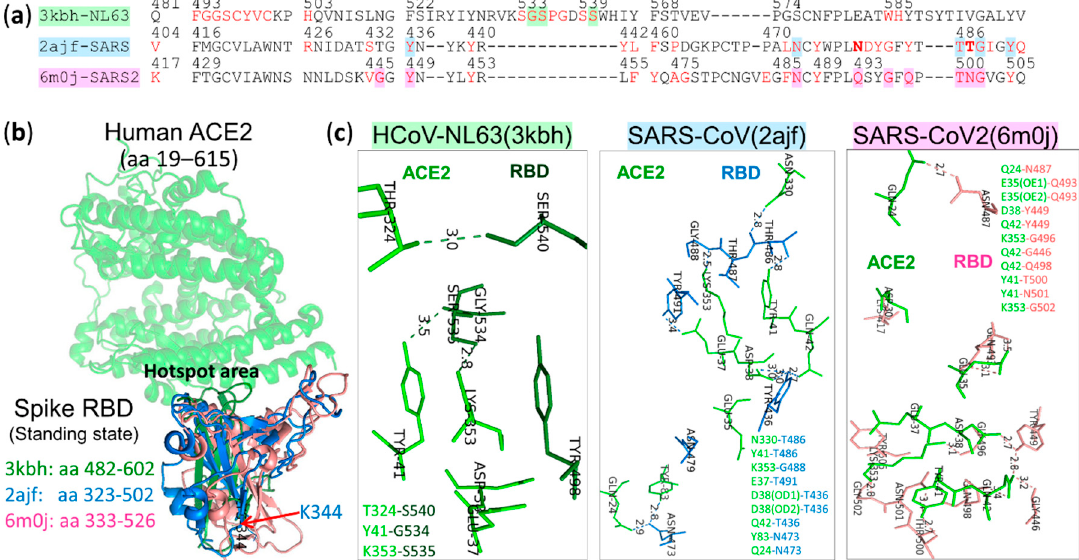
Figure 8. Comparison of receptor binding sites in S1-CTDs of HCoV-NL63, SARS-CoV and SARS-CoV2 binding to human ACE2. ( a ) S1-CTD receptor binding domains (RBDs) of HCoV-NL63 (pdb: 3kbh [232], forest), SARS-CoV (pdb: ajf [234], marine) and SARS-CoV-2 (pdb: 6m0j [235], salmon) in complex with human ACE2 (transparent green). ( b ) Direct interactions between amino acids of human ACE2 and those of the S1-CTD RBD of the indicated CoV. The bond lengths in angstroms are indicated on the dashed lines. ( c ) Alignment of aa sequences of the S1-CTD RBDs of the three CoVs binding to human ACE2. Amino acid residues in the S1-CTD RBDs facing the ACE2 receptor are colored in red. Residues in the S1-CTD RBDs of HCoV-NL63, SARS-CoV and SARS-CoV-2 directly interacting with residues in the ACE2 receptor are highlighted in green, blue and purple, respectively.